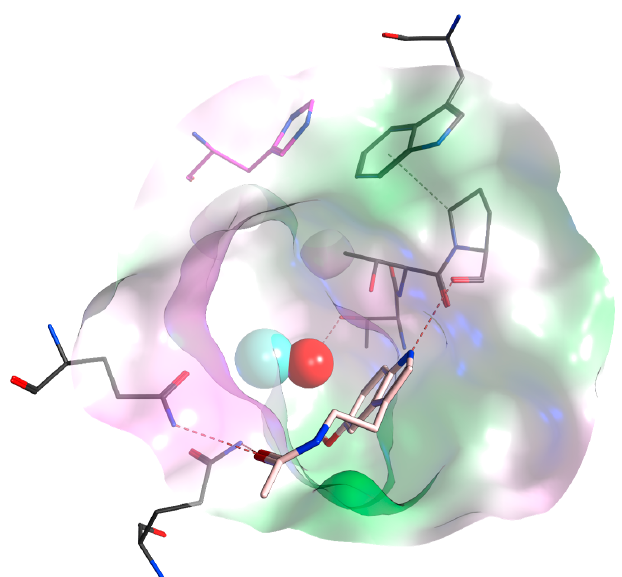
Figure 3. The docked pose of melatonin ( 2 ) in the active site of hCA VII. The proton shuttle His66 is shown in magenta.